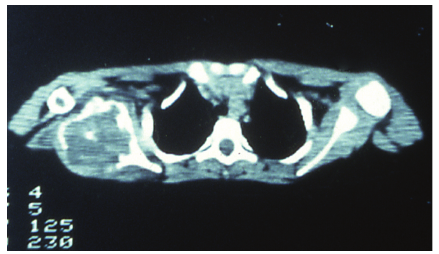
Figure 4: Computed tomography of the